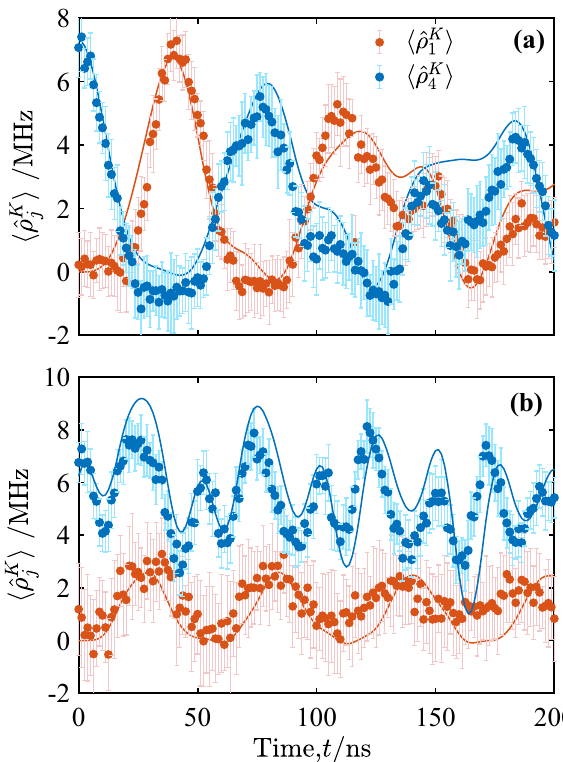
Fig. 4 Time evolution of kinetic energy densities at two edges, D E D E ð t Þ ð t Þ and ^ ρ K . Symbols are experimental data points, i.e., ^ ρ K 1 4 and the solid lines represent numerical results, where the decoherence and dephase are considered. The initial state is X þ X þ 000 j i . Each point shows the average of 10 × 200 single-shot measurements, and the estimate method of errors is presented in “ Methods ” . a F /2 π = 0 MHz. The energy densities h ^ ρ K i and h ^ ρ E i can 1 4 almost exchange into each other indicating that the energy transport is free in this case. b F /2 π = 15 MHz. There is no crossing ð t Þi and h ^ ρ K ð t Þi . The existence of this energy between the curves h ^ ρ K 1 4 gradient between two edges shows that the energy transport is compressed. That is, the energies at one side can hardly spread to the other